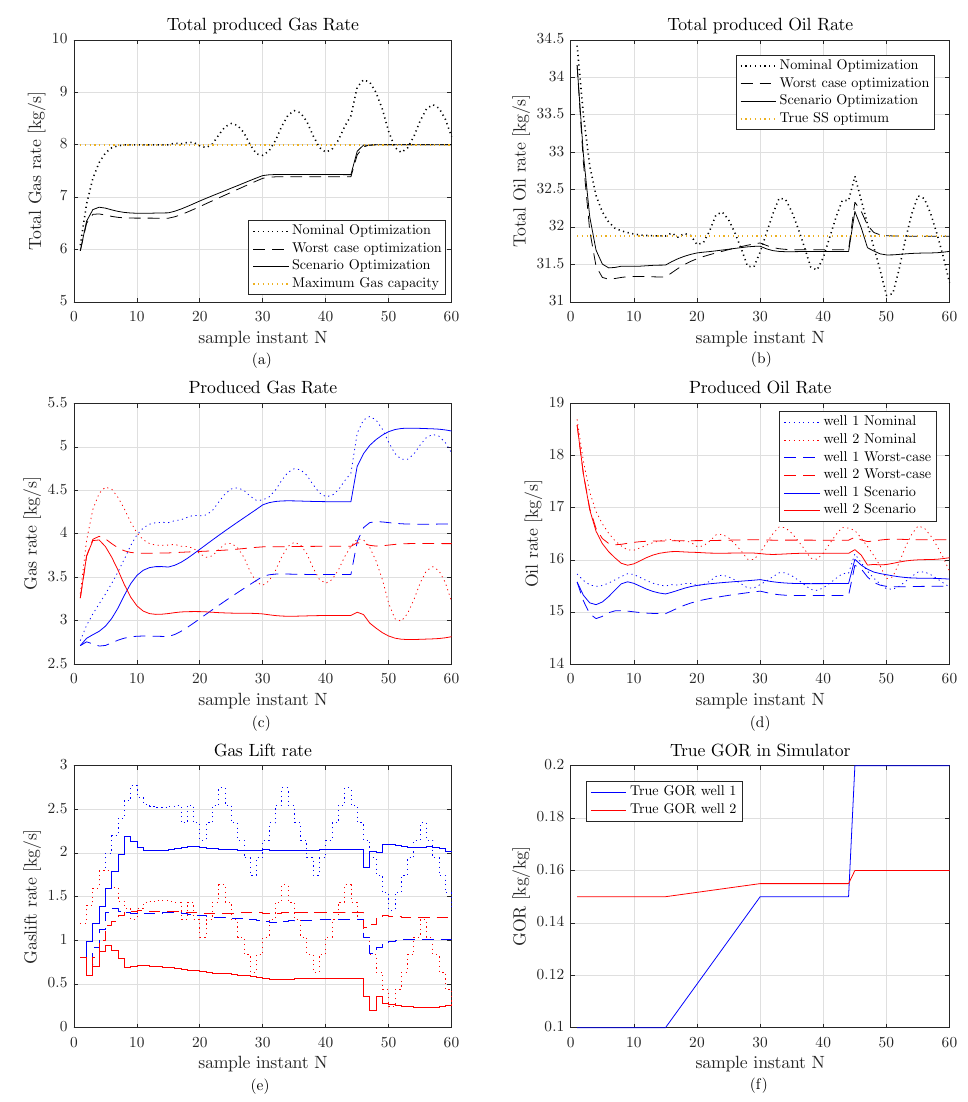
Figure 6. Simulation results for the nominal case (dotted), worst case (dashed) and scenario-based optimization (solid). ( a ) The total gas rates are shown in black and the maximum gas capacity constraint shown in yellow, ( b ) the total oil rates are shown in black and the true steady-state optimum for the oil rate is shown in yellow, ( c ) the gas rates from individual wells are shown in blue and red for well 1 and well 2, respectively, ( d ) The oil rates from individual wells are shown in blue and red for well 1 and well 2, respectively, ( e ) The gas lift rates from individual wells are shown in blue and red for well 1 and well 2, respectively. ( f ) The true GOR (gas-oil ratio) realization used in the simulator are shown in blue and red for well 1 and well 2,